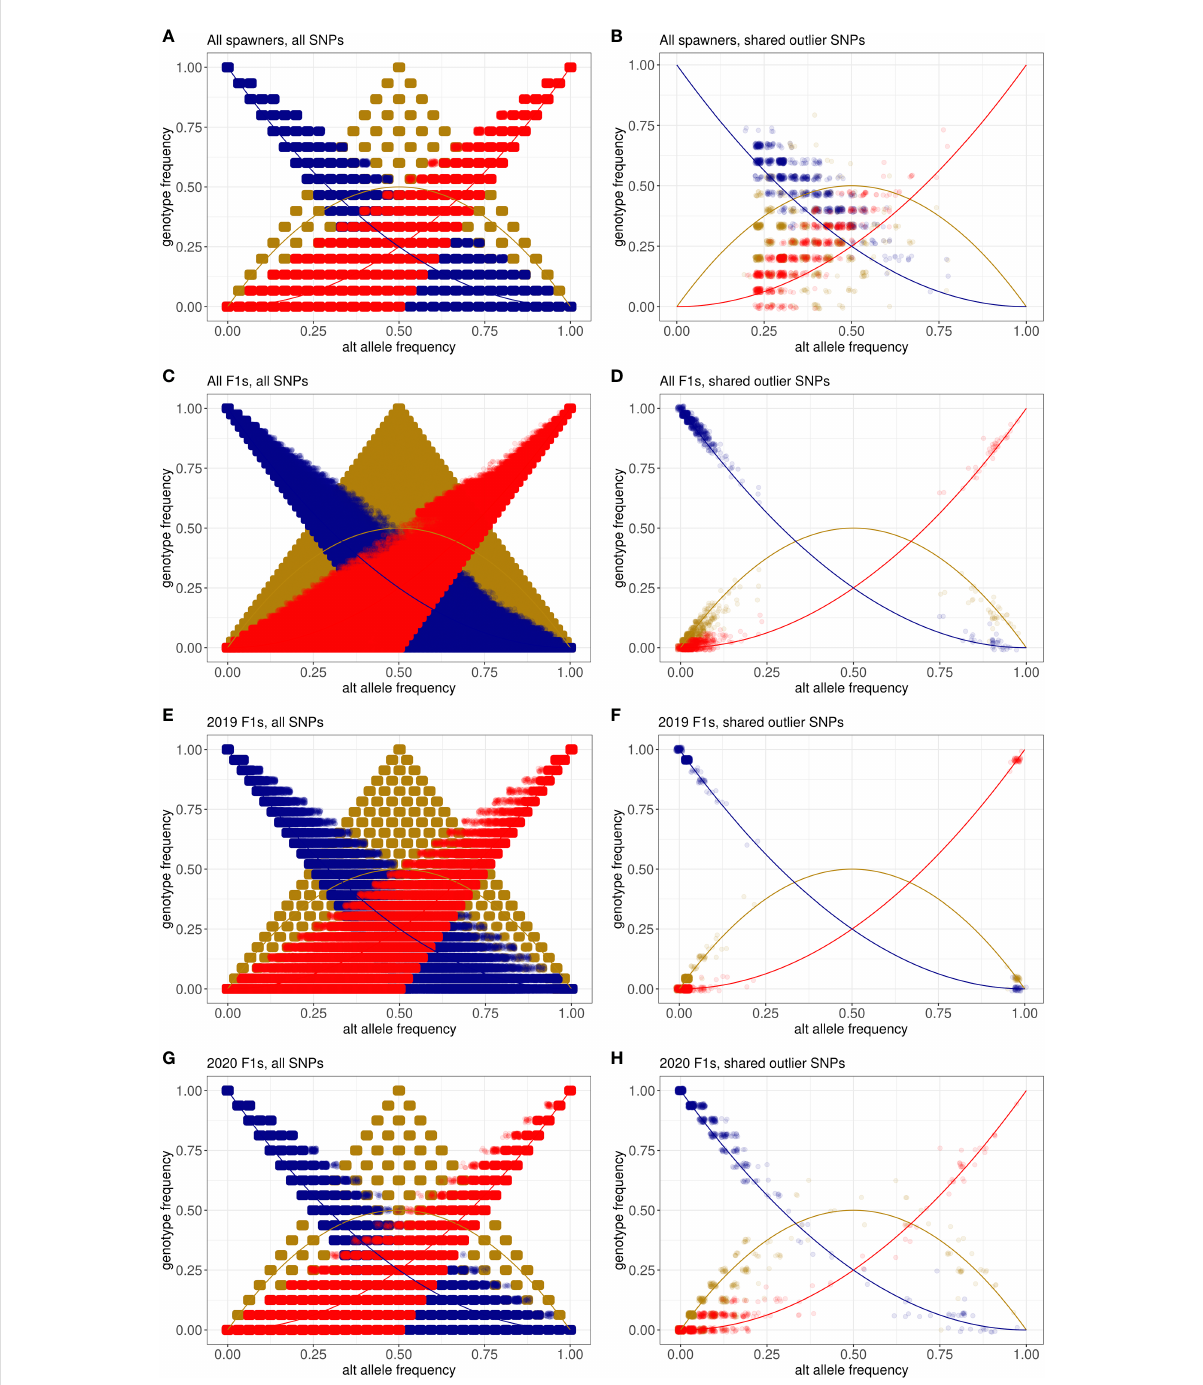
FIGURE 7 Relationships between the alternate allele frequency and genotype frequency for three genotypes: homozygous reference (blue), heterozygous (gold), and homozygous alternate (red). Equations describing the relationship between alternate allele frequency and genotype frequency expected under Hardy-Weinberg equilibrium for each genotype are represented by lines, while the points are the observed values seen in individual SNPs in each dataset. The observed relationships are shown for (A) all spawners at all SNPs, (B) all spawners at the 887 shared outlier SNPs, (C) all F1s at all SNPs, (D) all F1s at the shared outlier SNPs, (E) the 2019 F1s at all SNPs, (F) the 2019 F1s at the 887 outliers, (G) the 2020 F1s at all SNPs, and (H) the 2020 F1s at the 887